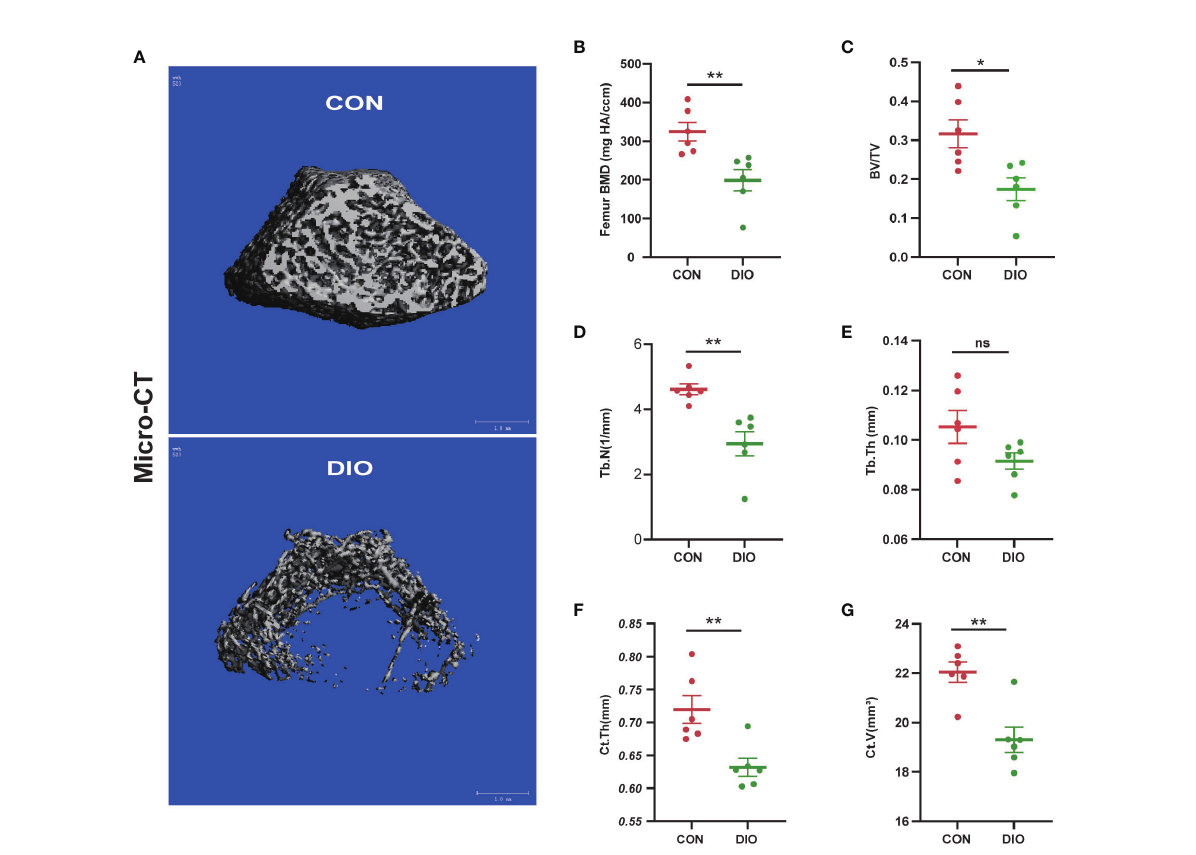
FIGURE 1 DIO-induced bone loss in rats. (A) Representative Micro-CT 3D reconstructions of the two groups. (B – E) Trabecular bone parameters at the distal femoral metaphysis after 10 weeks, including BMD, BV/TV, Tb.N, and Tb.Th. (F, G) Cortex bone parameters at the middle femur after 10 weeks, including Ct.Th and Ct.V. Data are expressed as the mean ± SEM. n = 6, *P < 0.05, **P < 0.01, ns, no signi fi